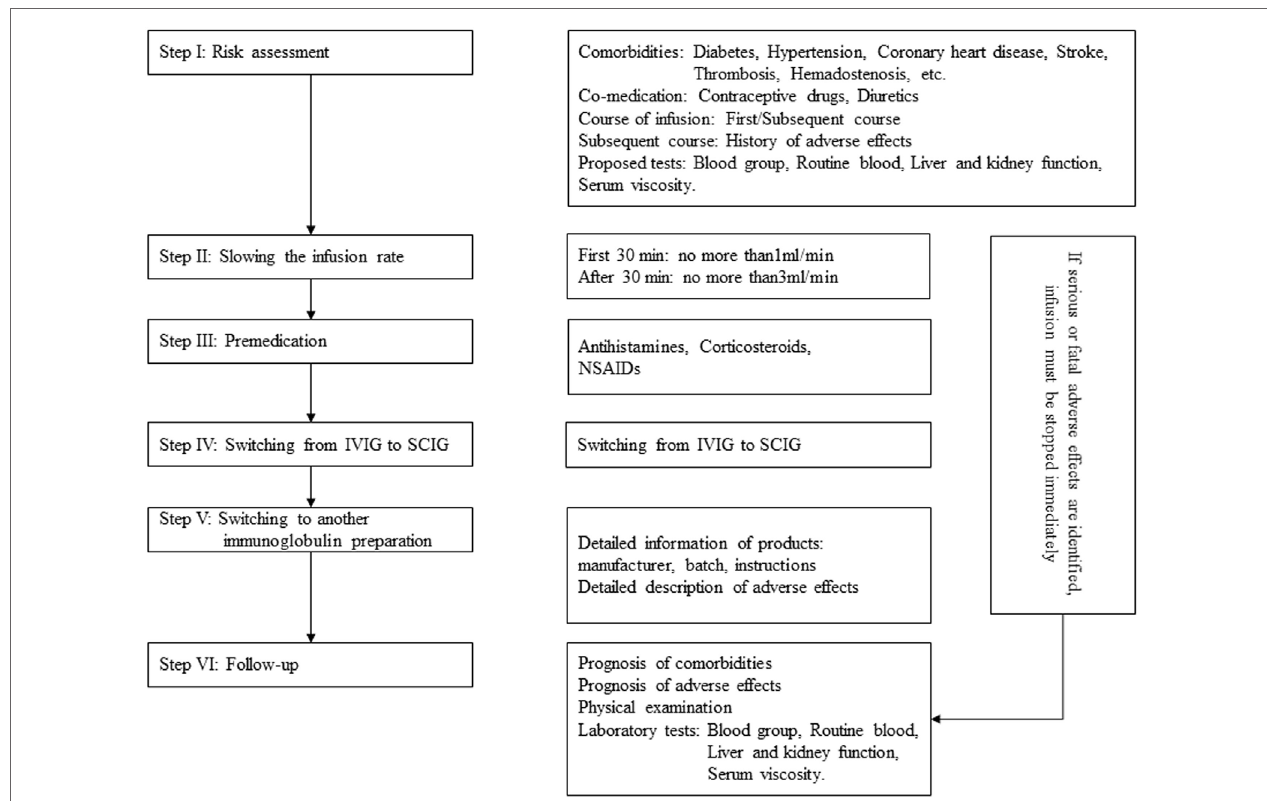
FigURe 1 | Process that minimizes or prevents immunoglobulin-associated adverse